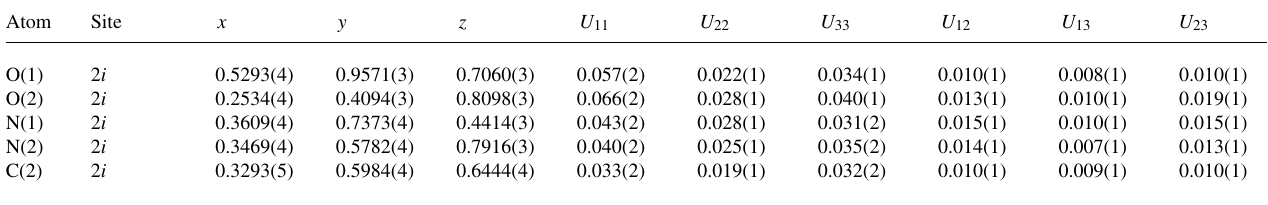
Table 3. Atomic coordinates and displacement parameters (in Å 2 )